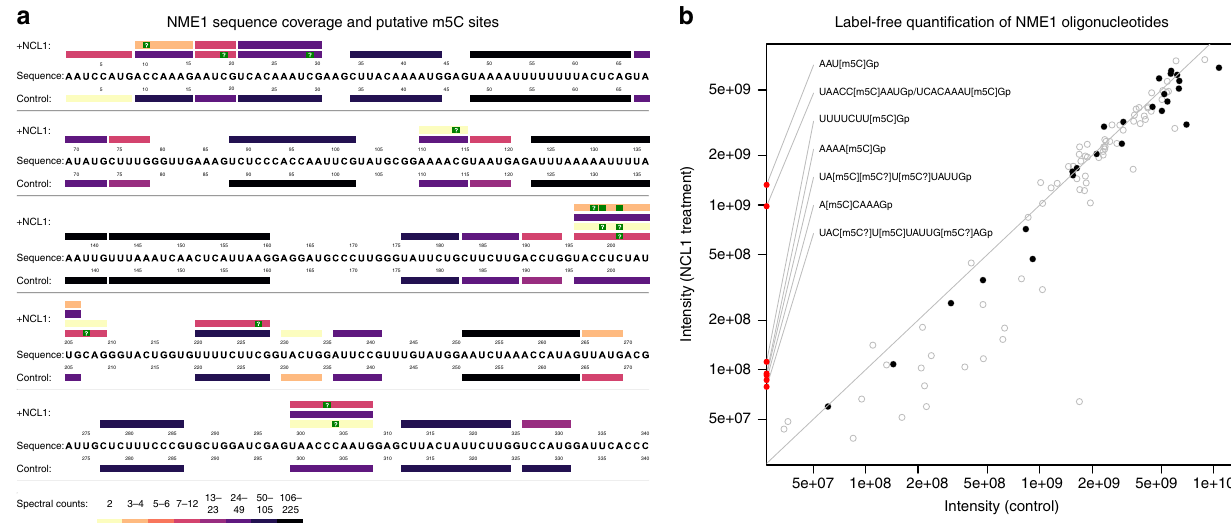
Fig. 3 Comparison of the NME1 control and NCL1-treated sample based on NASE search results at 1% FDR, without “ single hits ” . a Coverage plot showing oligonucleotides identi fi ed in the respective sample above/below the NME1 RNA sequence. Bars representing oligonucleotides are colored according to their number of spectral matches (spectral counts). Oligonucleotide identi fi cations supported by higher spectral counts (darker colors) are considered more reliable. Putative 5-methylcytidine (m5C) modi fi cation sites are marked in green. Sites with a “ ? ” , the one-letter code for m5C, were uniquely localized; “ blank ” sites indicate uncertainty between two possible locations, due to the absence of discriminating peaks in the corresponding mass spectrum. b Label-free quanti fi cation results for identi fi ed oligonucleotides, comparing feature-based signal intensities in the two samples (averaged across replicates). Gray circles show all individual charge/adduct states, while black dots indicate the “ best ” representative (lowest coef fi cient of variation across replicates) for quantifying each oligonucleotide. Oligonucleotides that were only identi fi ed and quanti fi ed in the NCL1-treated sample, all of them methylated, are depicted on the y axis. The notation “ [m5C?] ” is used here for cases where the methylation could not be uniquely localized. No modi fi ed oligonucleotides were identi fi ed in the control sample. The gray diagonal line represents equal intensity in both